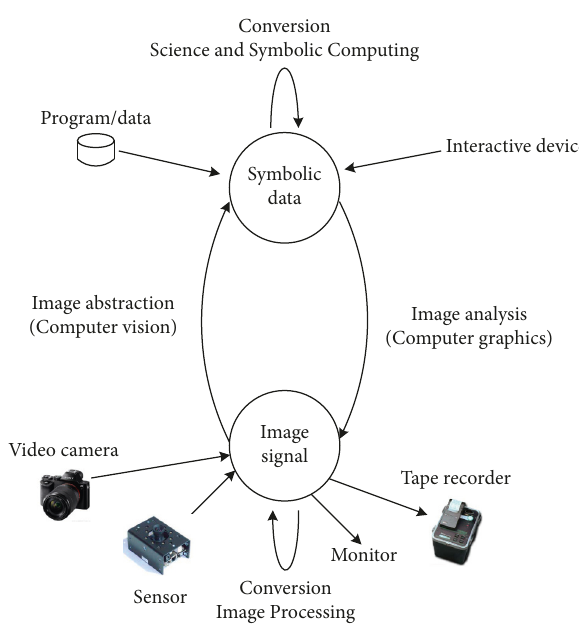
Figure 3: Scientific computing visual chemistry division classifi- cation